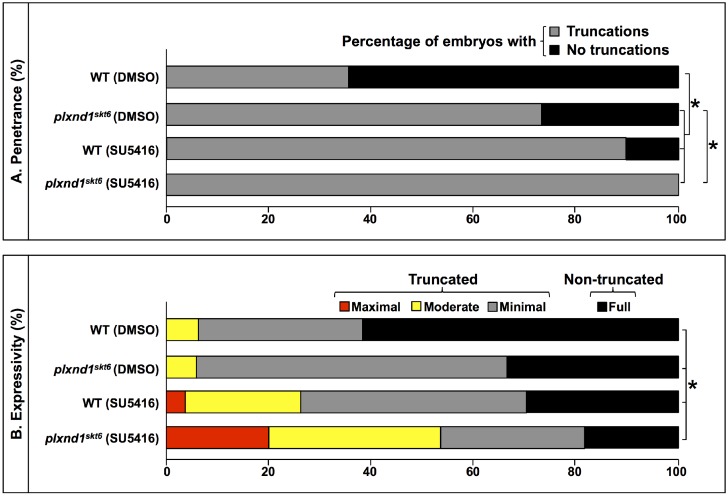
Penetrance and expressivity of Se-DLAV truncations in DMSO-treated and SU5416-treated WT and embryos and plxnd1skt6 mutants at 32 hpf.(A) Penetrance bar graph. Percentage of embryos of the indicated combinations of genotypes and treatments with Se-DLAV truncations (gray; a summation of the ‘minimal,’ ‘moderate,’ and ‘maximal’ categories) and with non-truncated Se-DLAV (black; ‘full’ category). Brackets and asterisks indicate pairs of genotypes with significantly different distributions of these two phenotypic classes as assessed by a two-sided Fisher Exact test, p<0.0083. (B) Expressivity bar graph. Percentage of ‘maximal’ (red), ‘moderate’ (yellow), and ‘minimal’ (gray) Se-DLAV truncations and of ‘full’ (black) non-truncated Se-DLAV in embryos with Se-DLAV truncations of the indicated combinations of genotypes and treatments. Brackets and asterisks indicate pairs of genotypes with significantly different distributions of the four phenotypic classes as assessed by a two-sided Fisher Exact test, p<0.0083. For additional supplementary information related to this figure, see Supplementary file 4. This figure is related to Figure 3.